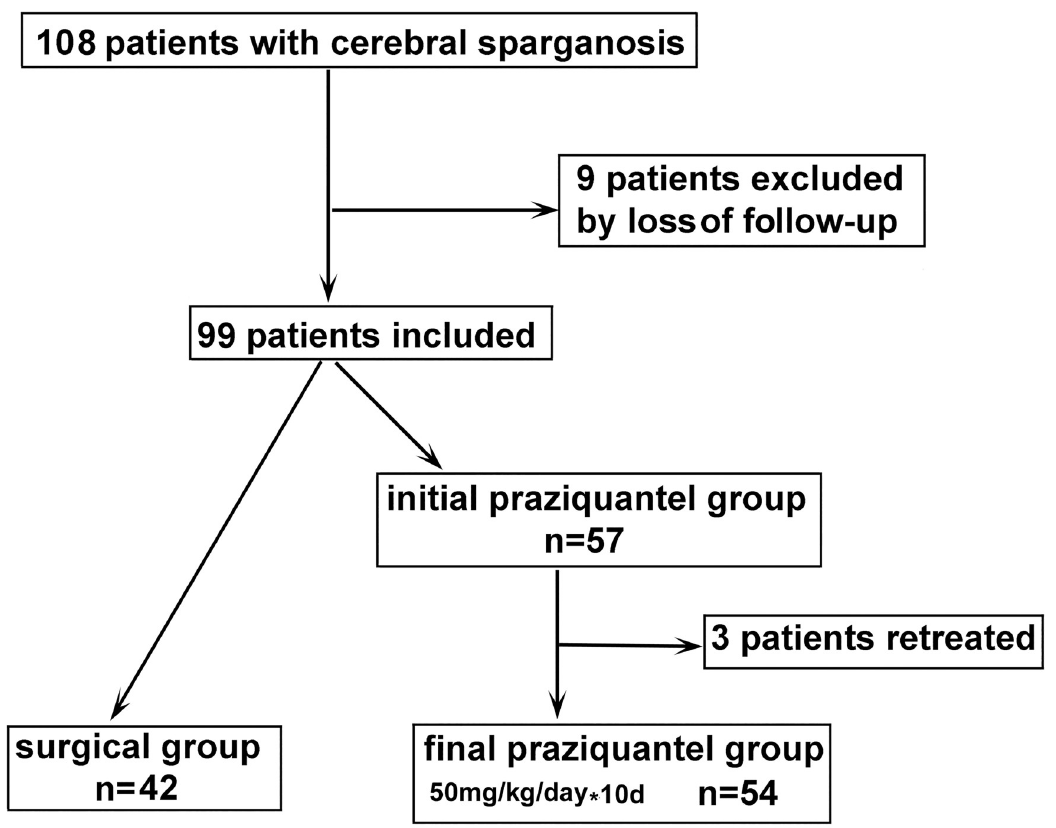
Fig 1. Flowchart of study enrollment and rationale for